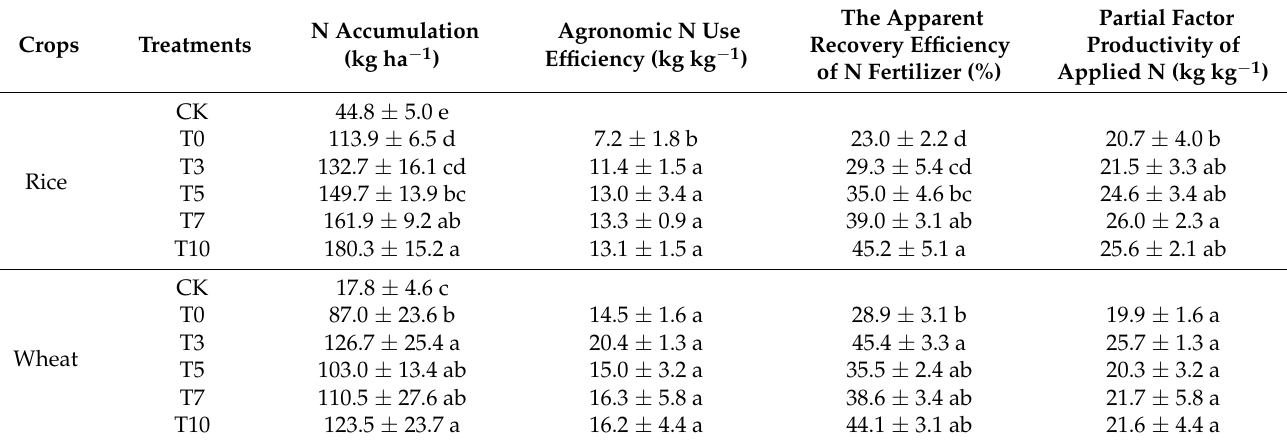
Table 2. Effects of different fertilization treatments on nitrogen accumulation and NUE in rice and wheat.